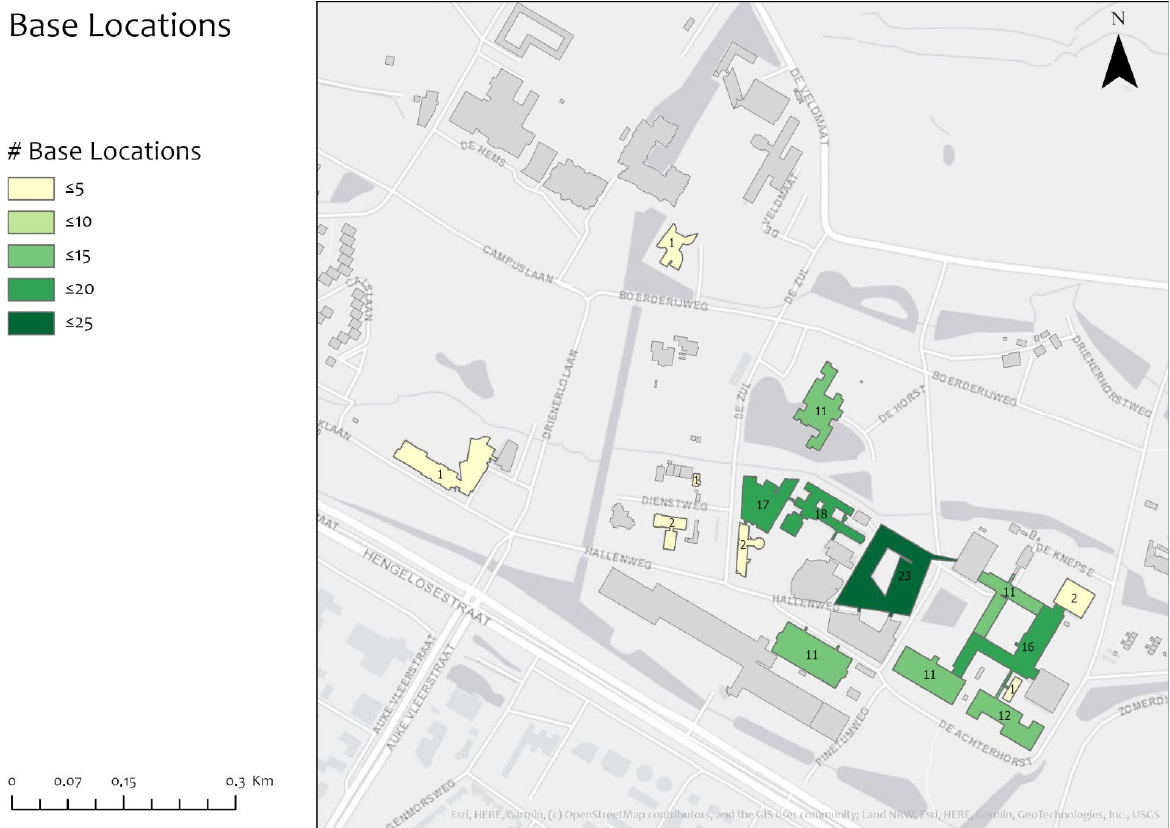
Figure A3. UT campus—number of base locations. # = ‘Number of’.